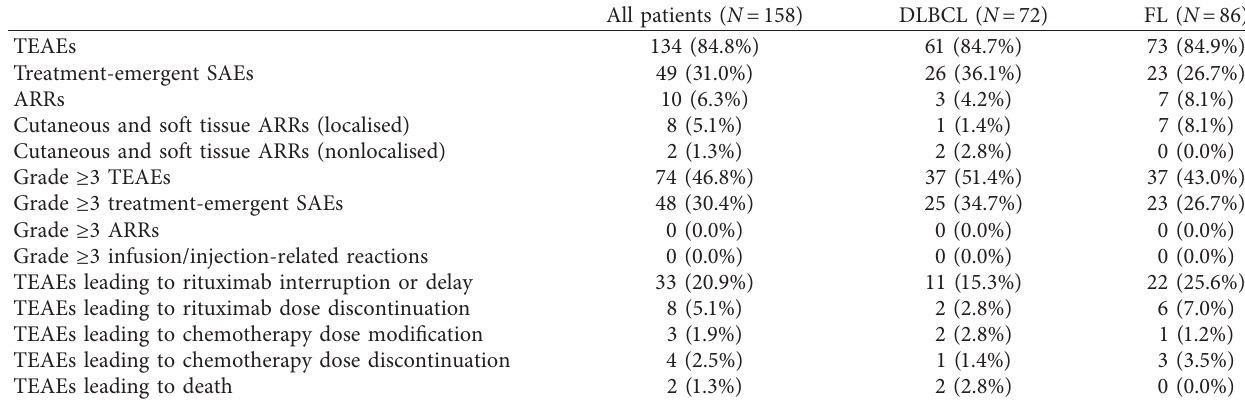
Table 3: Overall summary of adverse events. Data are number (%) of patients.